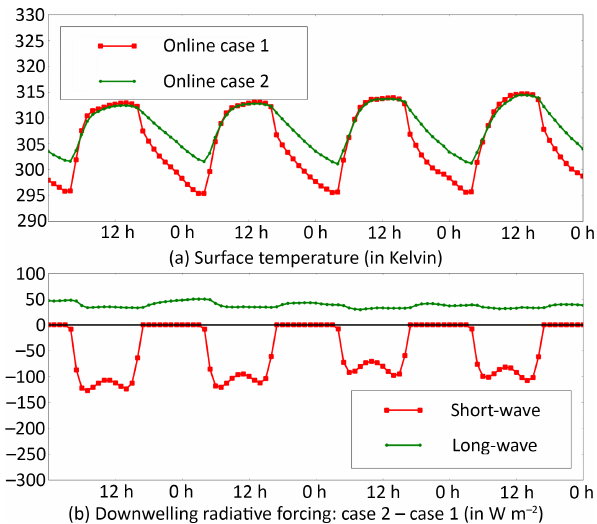
Figure 10. Surface temperature and downwelling radiative forcing 4-day time series (1 to 4 June) over a grid cell in north-eastern Niger (GMT time).